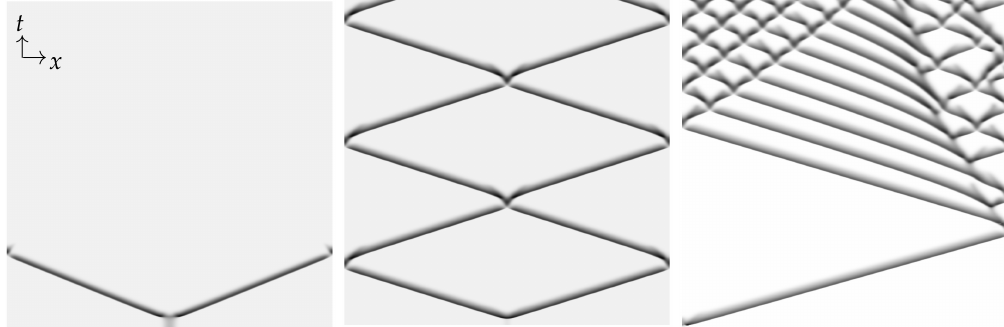
Figure 3. Space–time plots showing (from left to right) annihilation, reflection/crossover, and “birth” of new pulses following collision (a behavior that resembles backfiring), respectively, as obtained from direct numerical integration of the minimal CDR model equations [151] that have the same structure as Equations (5). No-flux boundary conditions were used. From left to right the amount of actin monomers increases (see details in [151]). The dark shaded color indicates higher values of filamentous actin in the IAW. Reprinted figure with permission from the work in [151] Copyright 2020 by the American Physical